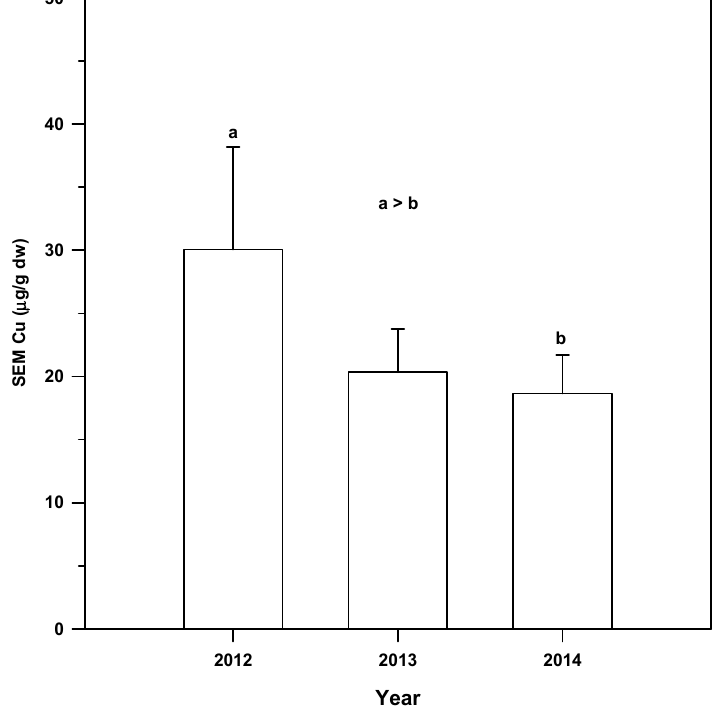
Figure 24. All Fall Cache Slough SEM Cu sediment data by year (Kruskal-Wallis One Way ANOVA on Ranks, p = 0.026). a,b: The year 2012 is significantly different from the year 2014 (Tukey Method, p ≤ 0.050).